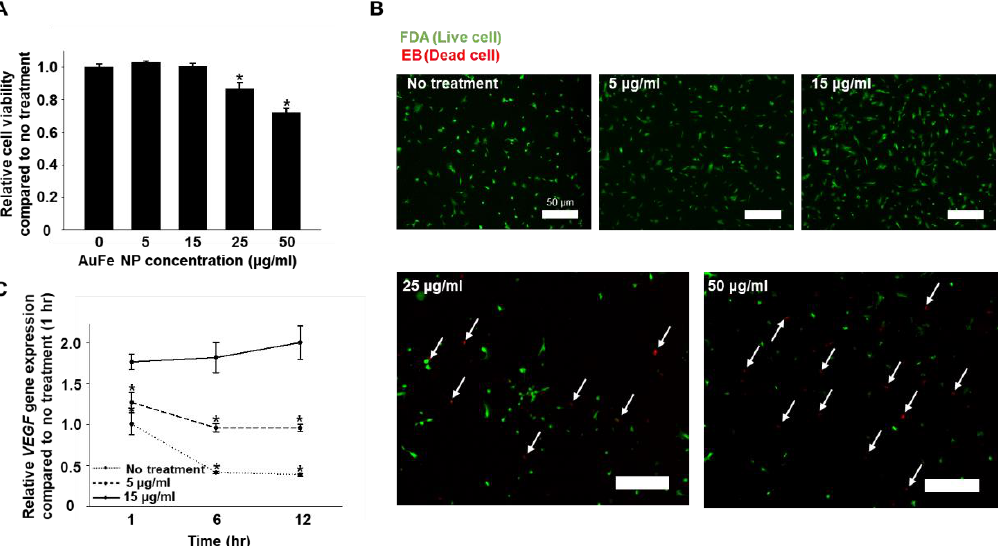
Figure 2. ( A ) Cytotoxicity test performed on hMSCs, 24 h after treatment with various concentrations of AuFe NP (0, 5, 15, 25, and 50 μg/mL) ( n = 4, * p < 0.05 compared to no treatment). ( B ) FDA/EB assay to measure hMSC viability, 24 h after treatment with various concentrations of AuFe NP. Live cells are stained in green and dead cells (white arrows) are stained in red. Scale bars represent 50 μm. ( C ) Relative mRNA expression of VEGF in hMSCs treated with various concentrations of AuFe NP for 1, 6, and 12 h, as evaluated by qRT-PCR ( n = 4, * p < 0.05 versus AuFe NPs 15 μg/mL group).